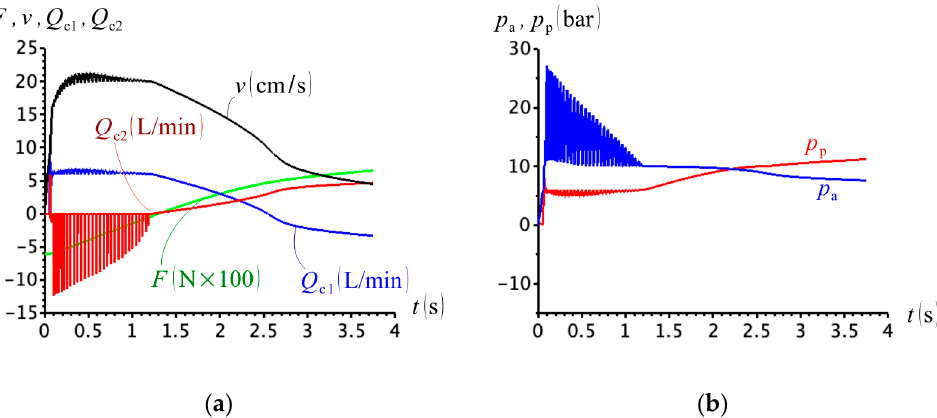
Figure 19. ( a ) External force, cylinder velocity and compensation flows; ( b ) cap- and rod-side pressures ( m = 250 kg ) .